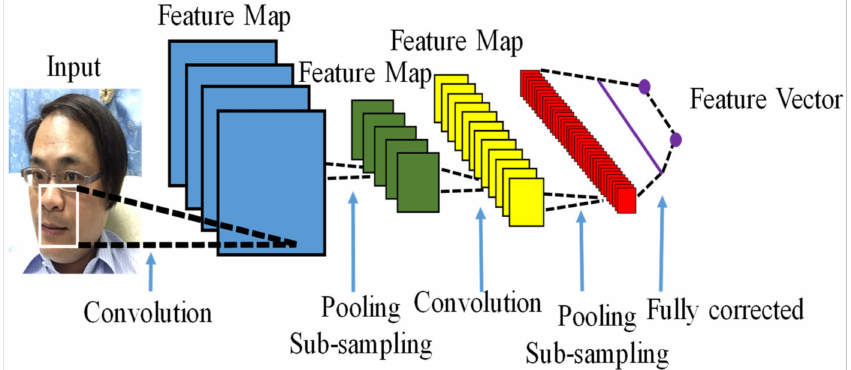
Figure 4. The proposed architecture for CNN